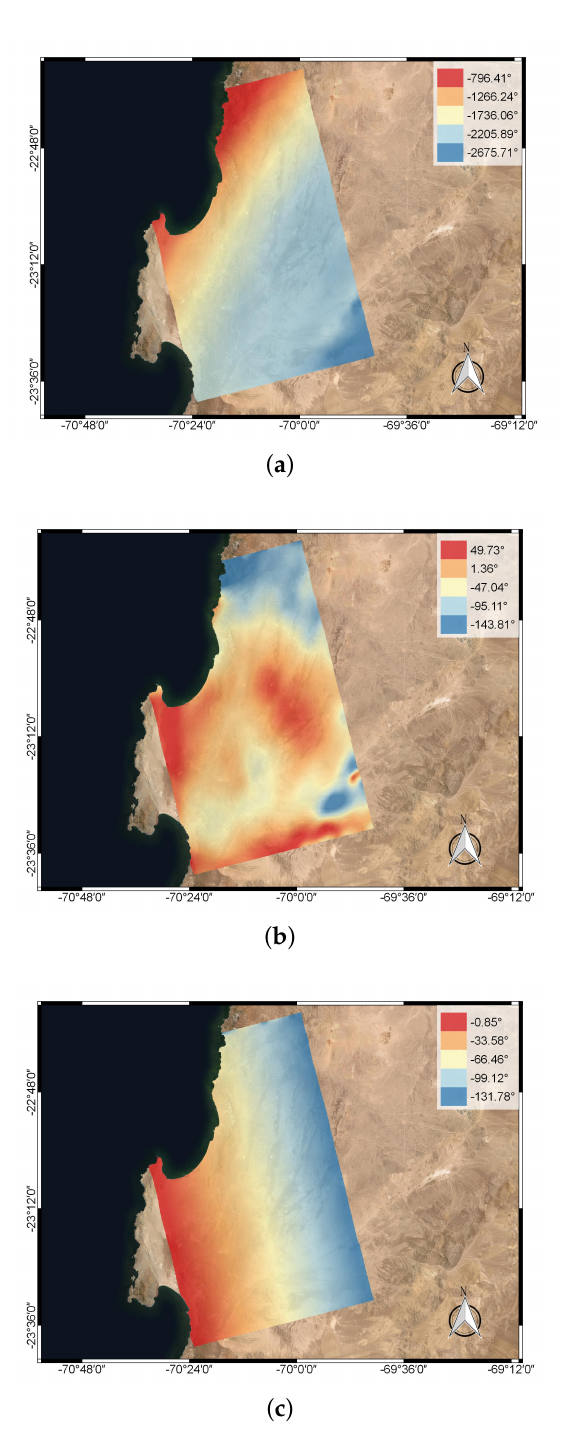
the ionospheric phase and the corrected DInSAR phase. The ionospheric correction result is shown in Figure 11. The difference between the corrected DInSAR phase with baseline error and the corrected DInSAR phase without parameter error from Figure 9c is shown in Figure 11c. The linear fringes in Figure 11c show the features of orbital error.